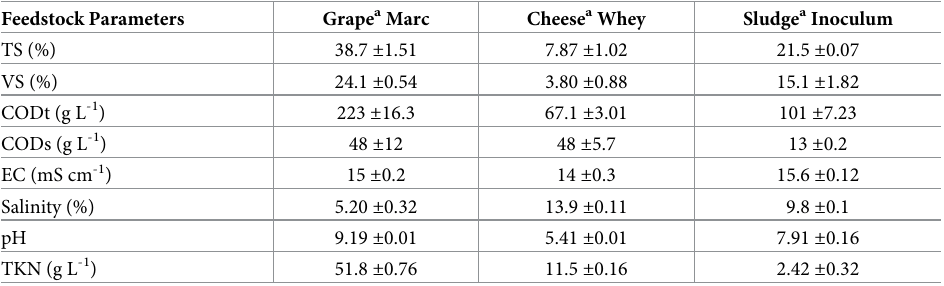
a Data recorded as mean ± standard error; TS, total solids; VS, volatile solids; CODt, total COD; CODs, soluble